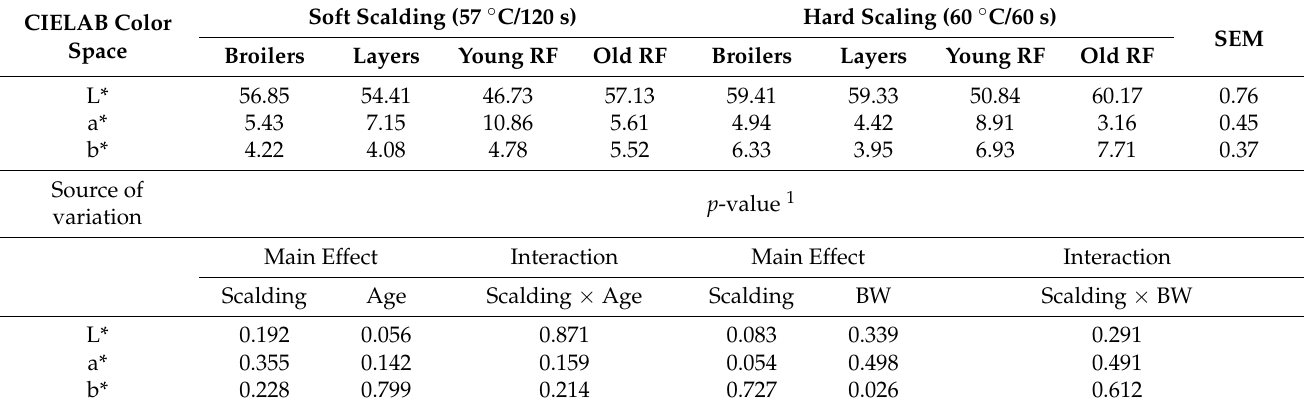
Figure 3. The defeathering effectiveness of soft and hard scalding in different breeds of chickens. According to the distribution of defeathering scores (Figure 1), the total scores less than 9 were regarded as effective defeathering procedure, while scores larger than 10 were unacceptable. Results were expressed as a percentage of total birds of each group with total score less than 9 in the 5–15 scale. Means with different superscript letters within the same row differ significantly among breeds ( p < 0.05, n = 20). * significant differences vs. soft scalding (57° C/120 s) ( p < 0.05, n = 20). Broilers (2.6 kg/bird) and layers (1.8 kg/bird) at age of 7 and 53 weeks, respectively. RF: Red Feather country chickens at age of 12 (young, 2.7 kg/bird) and 40 (old, 2.6 kg/bird) weeks.